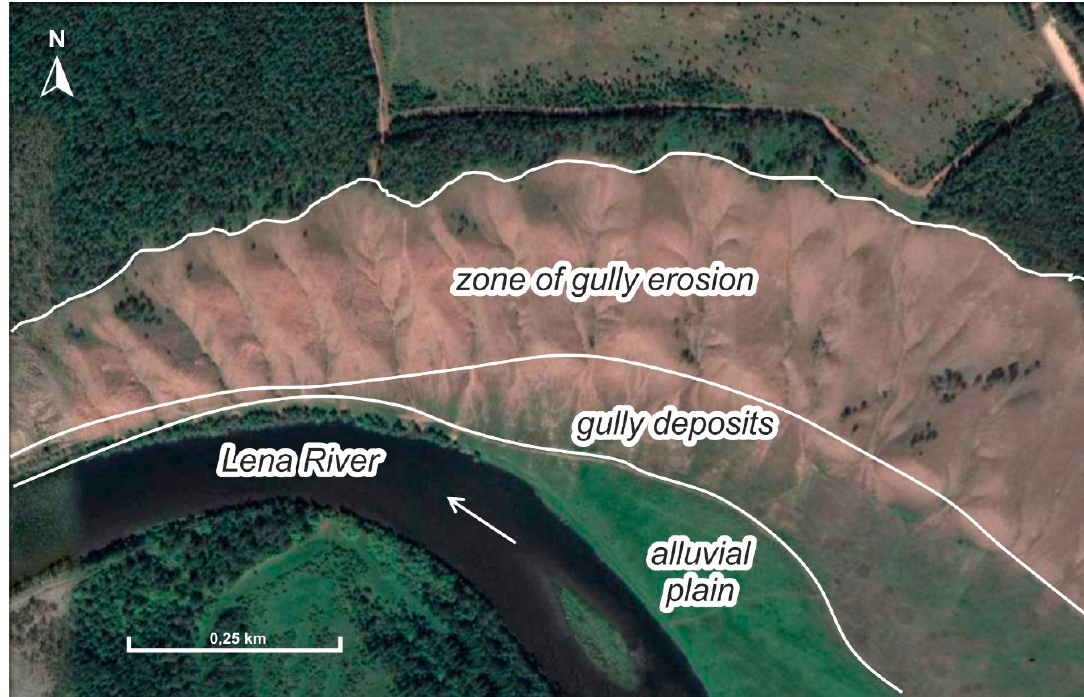
Figure 6. Gullies cutting the steep walls of the Lena river valley near the settlement of Kachug. Coordinates: 53°59 ’ 42.93 ’’ N, 105°49 ’ 48.40 ’’ E. The image was taken on July 19, 2018. Based on the satellite image Google Earth.